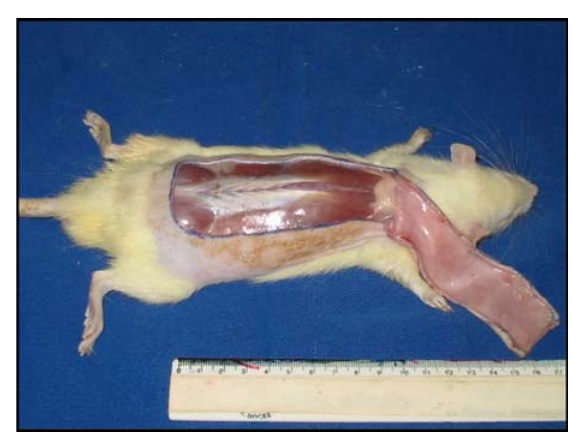
FIGURE 2 - Random skin flap raised